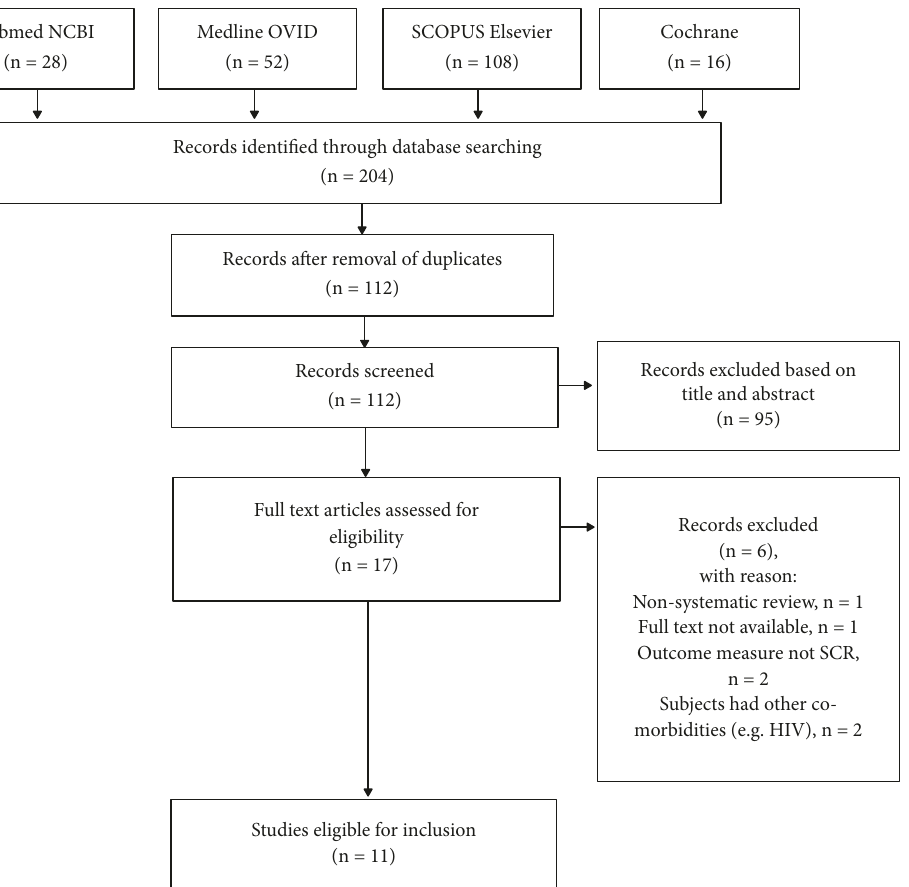
Figure 1: PRISMA flowchart outlining the process of article